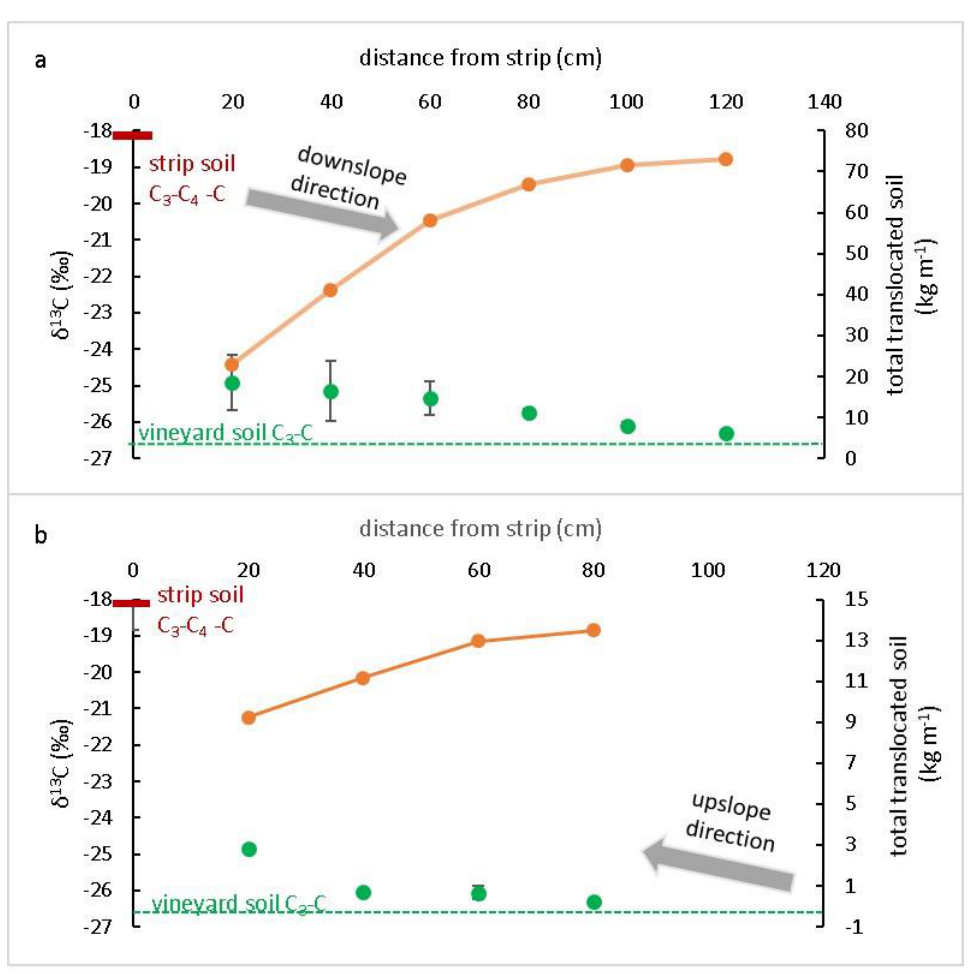
Figure 3. δ 13 C values (‰) and total translocated soil (kg m −1 ) in ( a ) downslope tillage and ( b ) upslope tillage.